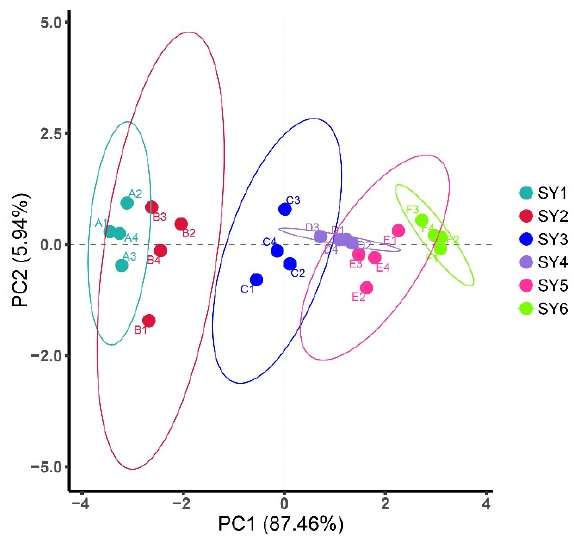
Figure 5. PCA plot showing the attribution of soy yogurt groups over LAG addition with respect to sensorial characteristics. (SY1, 2, 3, 4, 5, 6 with 0%, 0.01%, 0.025%, 0.05%, 0.075% and 0.1% LAG concentration, respectively).